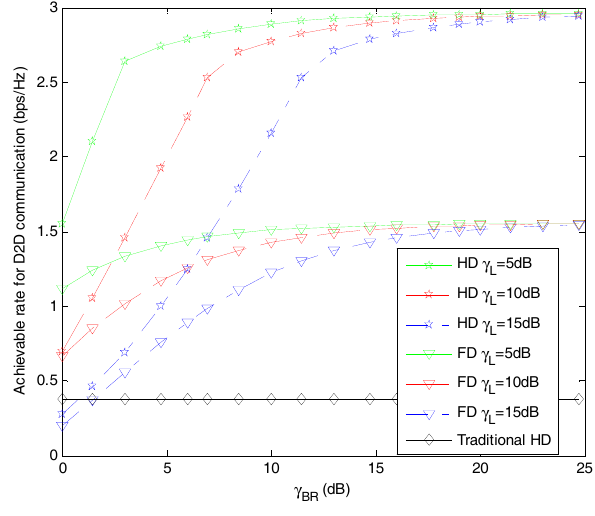
Figure 3. Rate achievement for D2D